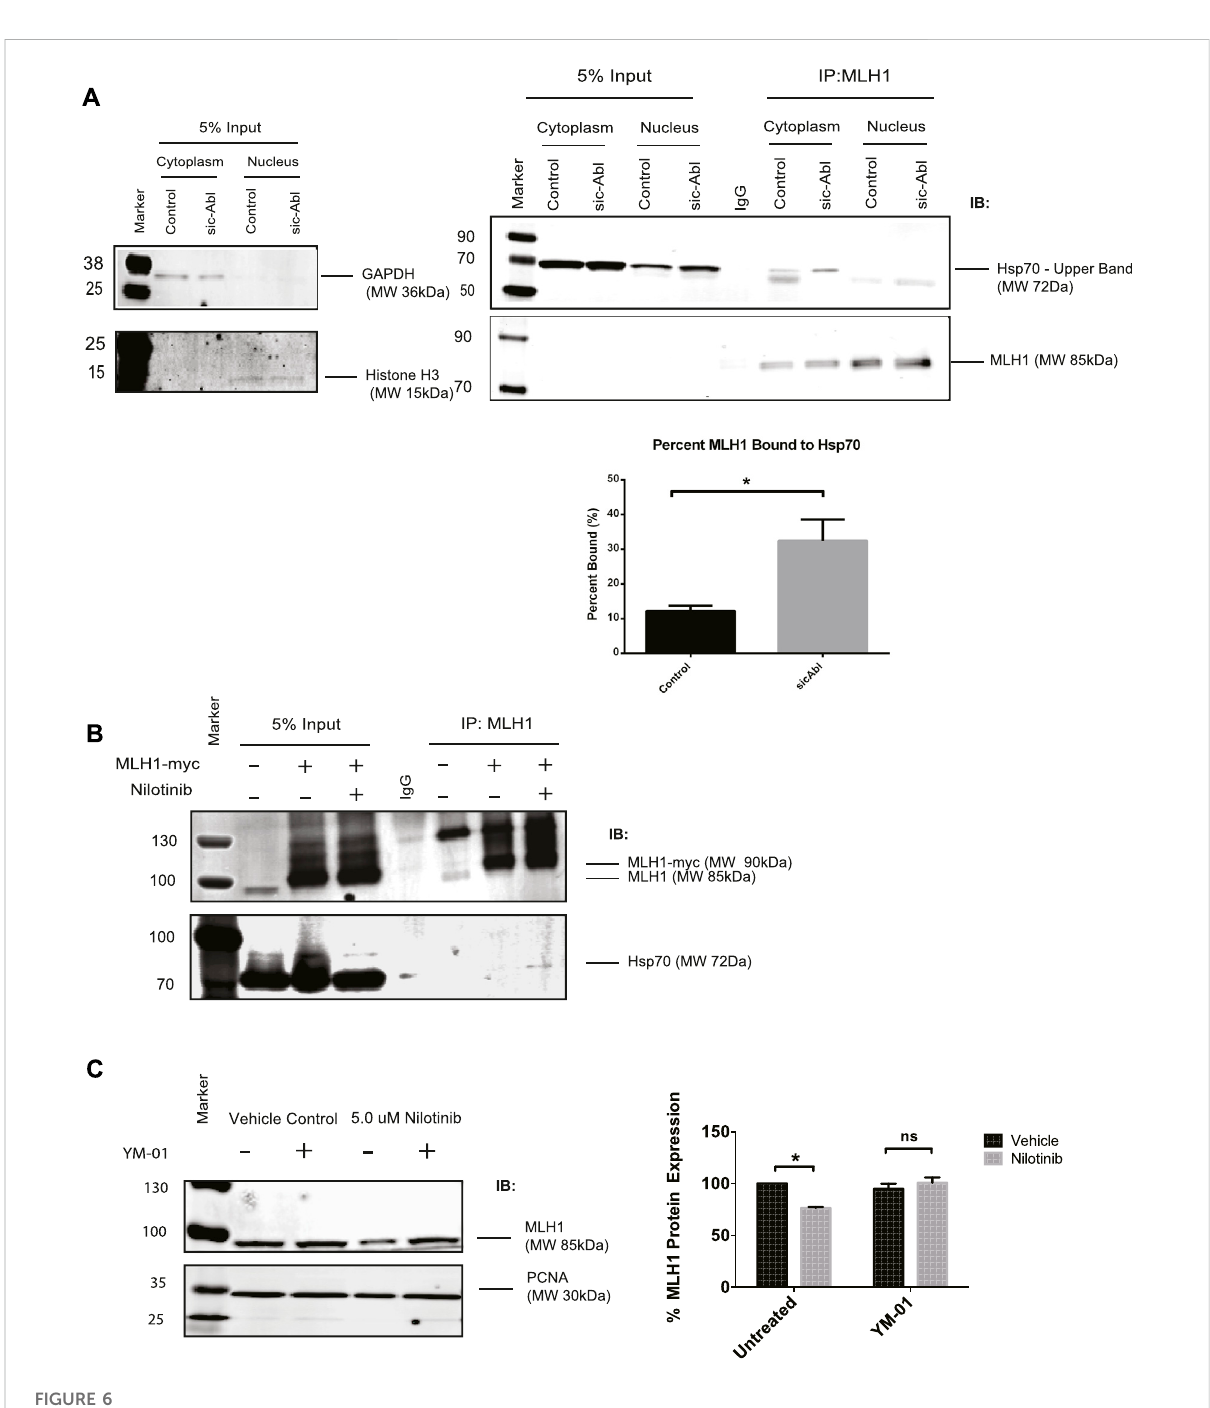
MLH1 binds to Hsp70 in the absence of ABL1 signaling and inhibition of Hsp70 restores MLH1 levels. (A) MLH1 immunoprecipitation from nuclear or cytoplasmic fractions in cells transfected with scrambled control or ABL1 siRNA followed by immunoblot for Hsp70 and MLH1. Cytoplasmic and nuclear fractionation purity was con fi rmed by GAPDH and Histone H3 immunoblots, respectively. Quanti fi cation of percent MLH1boundtoHsp70isshown. n =3,signi fi cancewasdeterminedbyunpairedt-test* p < 0.05. (B) MLH1immunoprecipitationfromwholecell lysate of HEK293 cells overexpressing MLH1 and treated with nilotinib or vehicle control, followed by immunoblot for Hsp70 and MLH1 (C) Immunoblot analysisand quanti fi cation ofMLH1proteinexpression inHEK293 cells after treatmentwith nilotinib orvehiclecontrol after 24